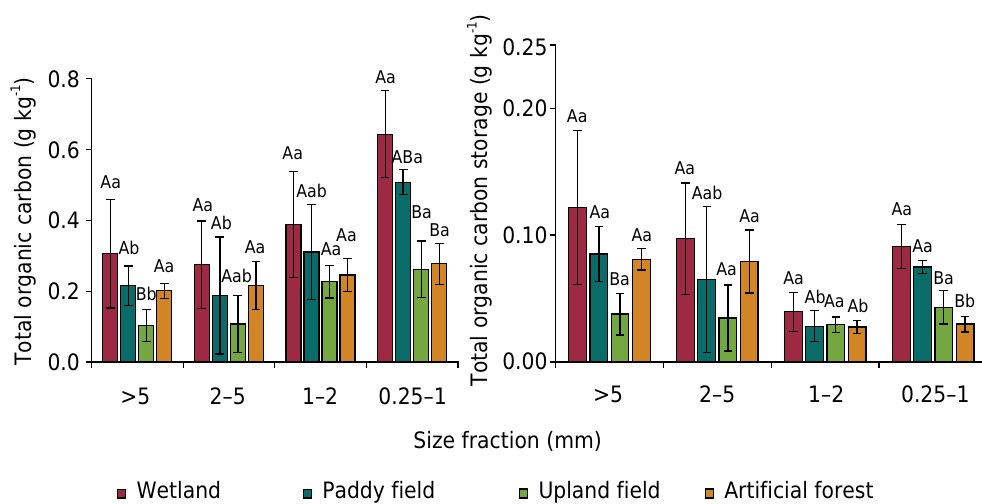
Figure 4. Content and storage of dissolved organic carbon in soil aggregates from different land-uses in the Sanjiang Plain wetlands. Capital letters represent the differences between different land-uses at the same soil aggregates. Lowercase letters represent the differences of the same land-use in different soil